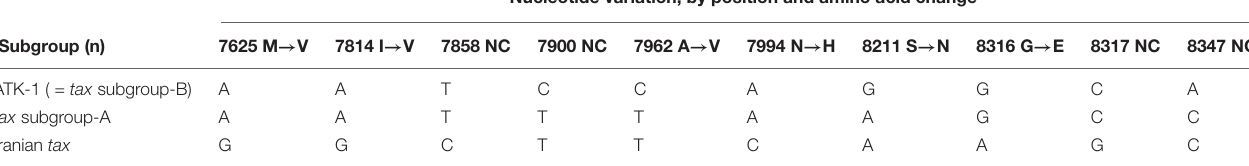
Nucleotide variation, by position and amino acid change a